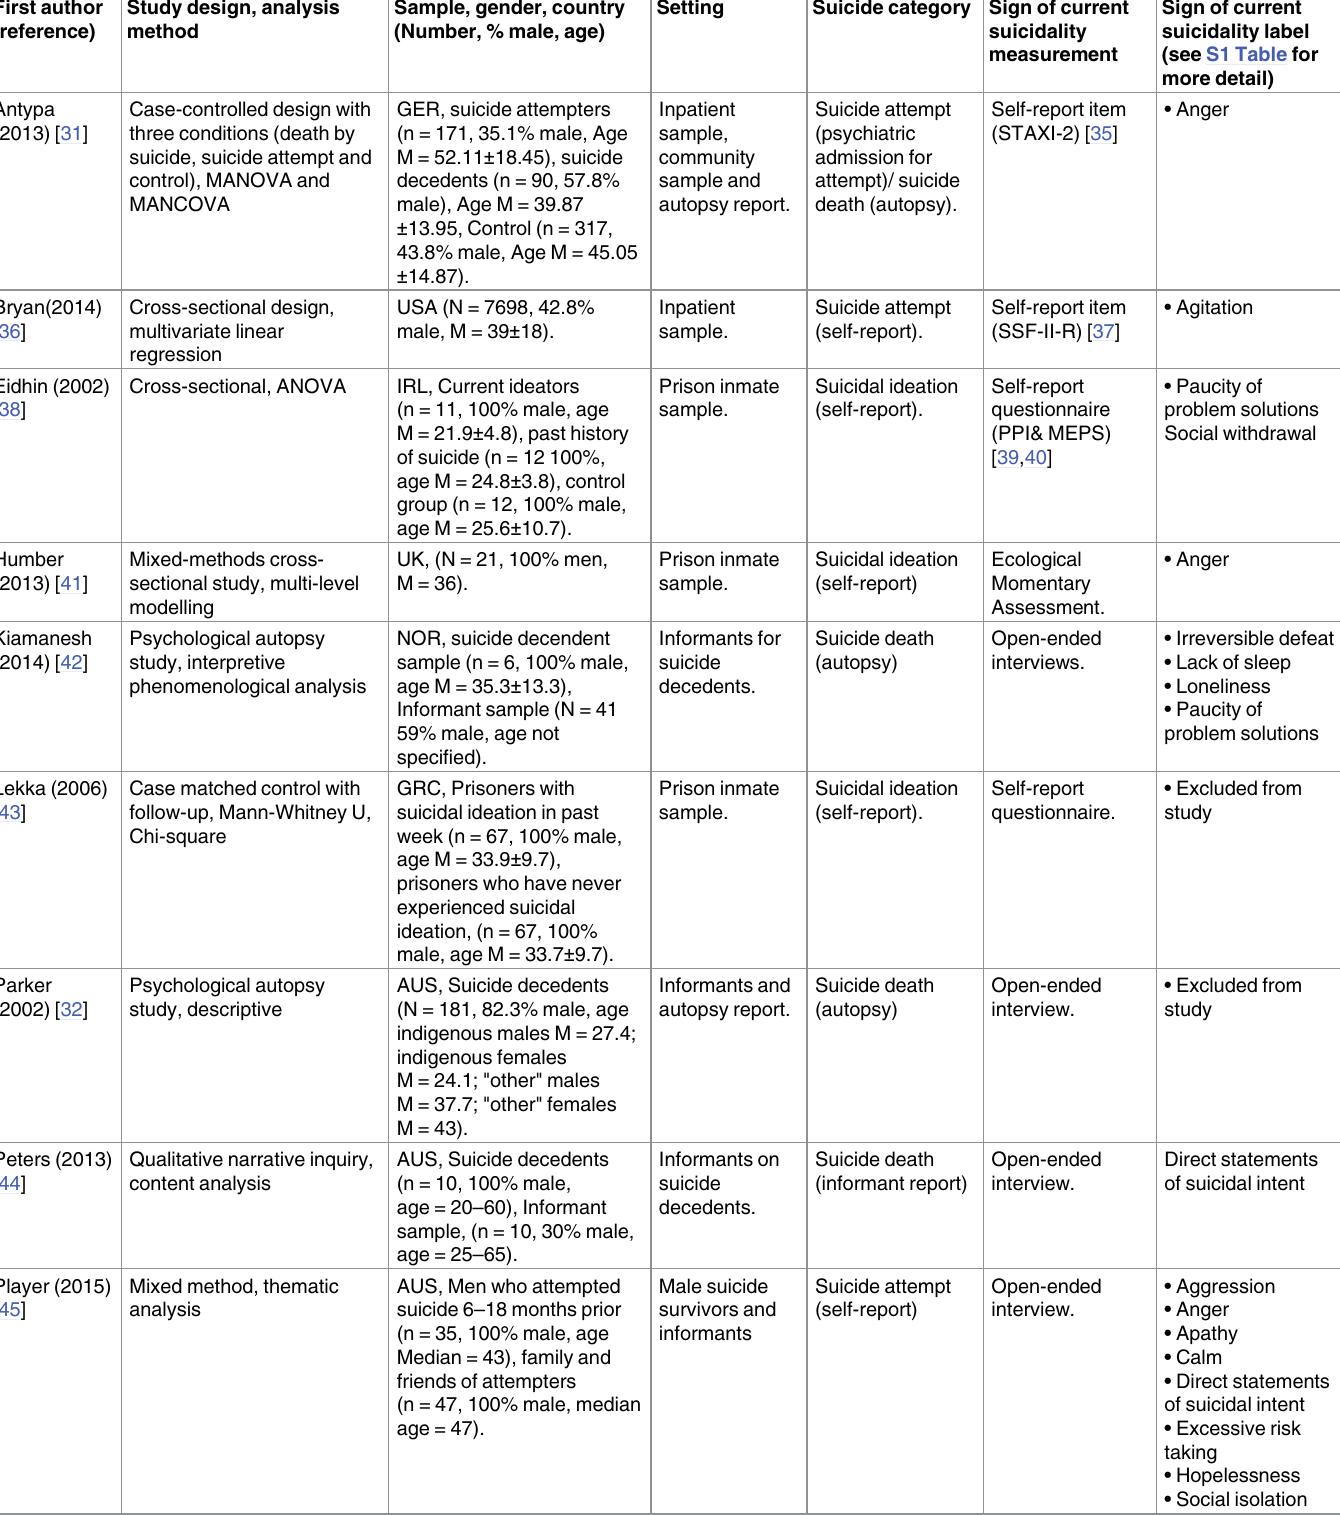
Table 2. Studies included in